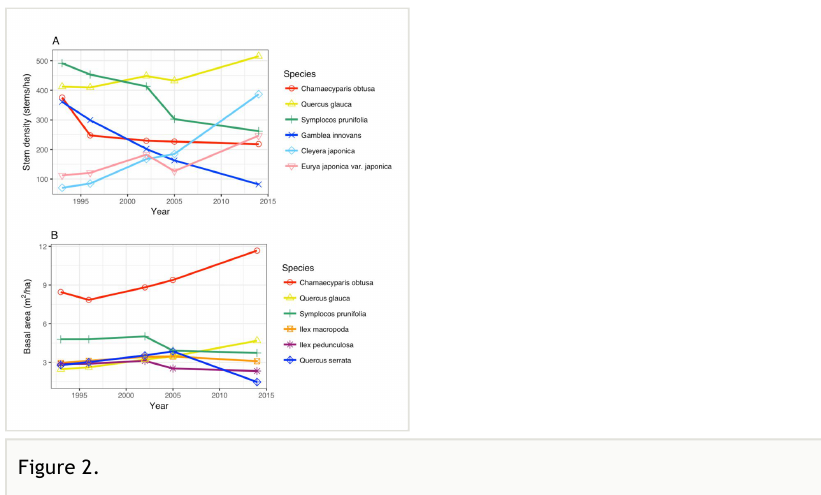
Figure 2. Changes in dominance of major species. A: stem density, and B: basal area.